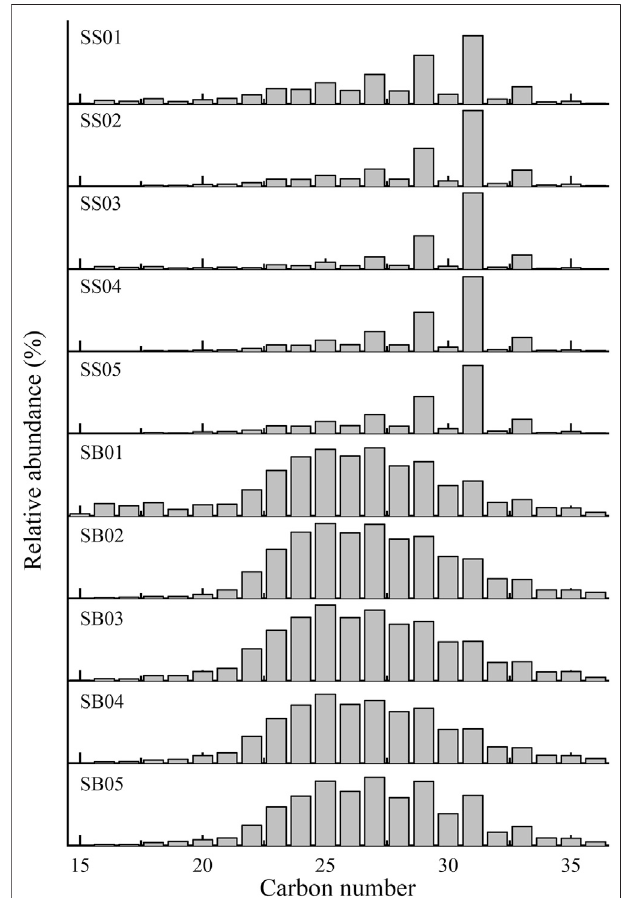
FIGURE 4 | Distribution of n -alkanes in different lithologic strata of salt lake sediments.